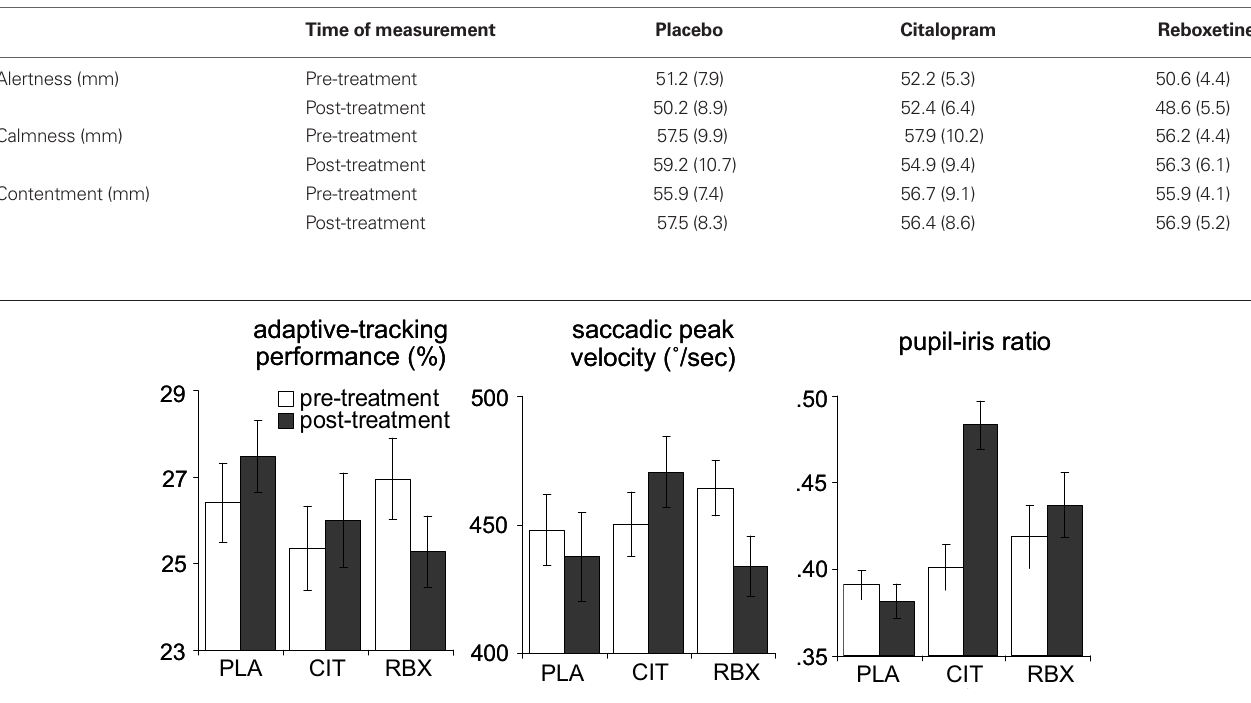
Table 1 | Pre- and post-treatment ratings of alertness, calmness, and contentment in the placebo, citalopram and reboxetine group (SD in parentheses).